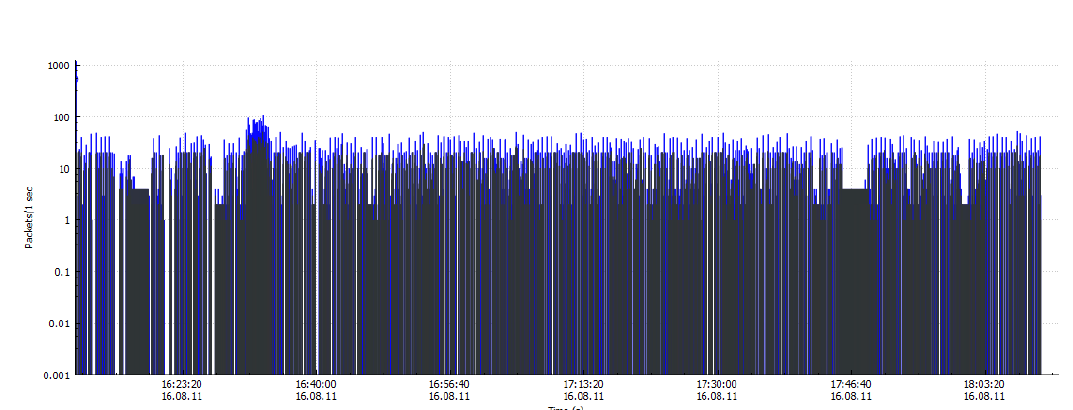
Figure 13. RBot Botnet captured.